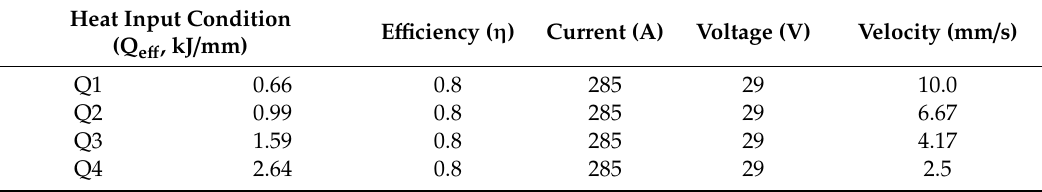
Table 5. Heat input conditions for welding analysis.